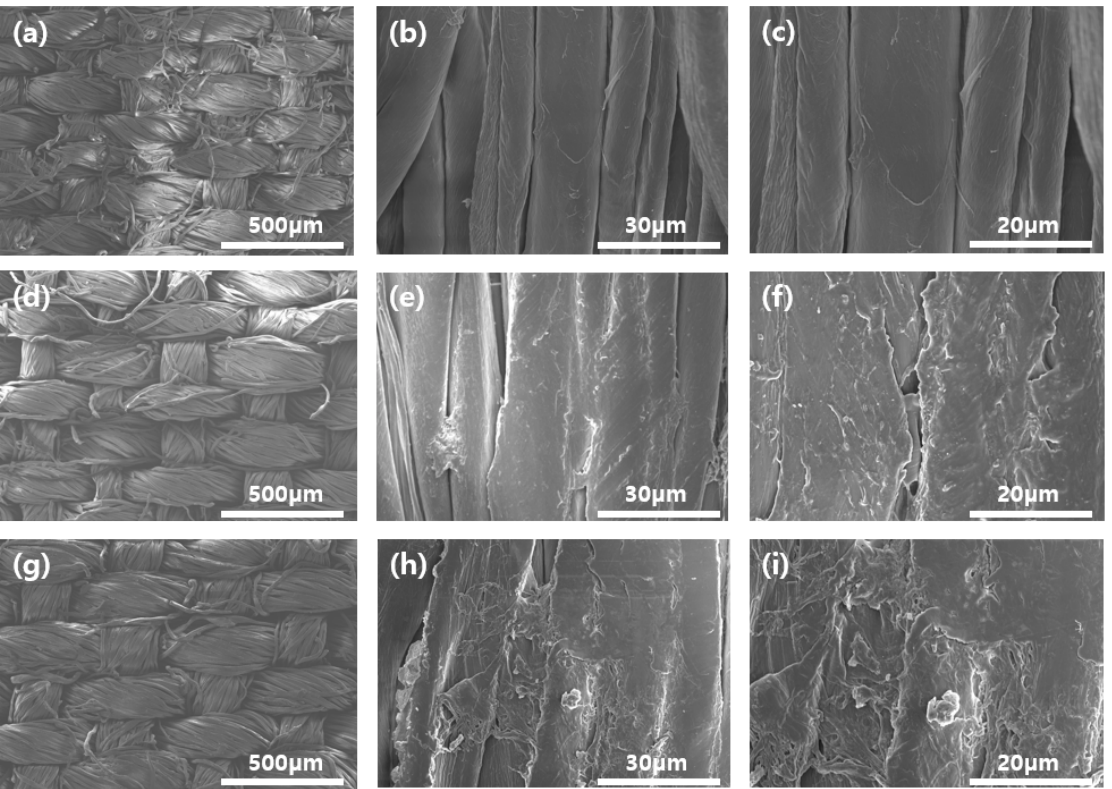
Figure 8. SEM images of the untreated, chitosan-treated, and Gu-chitosan-treated cotton fabrics under di ff erent magnifications: ( a – c ) untreated cotton fabric; ( d – f ) chitosan-treated cotton fabric; and ( g – i ) Gu-chitosan-treated cotton fabric.